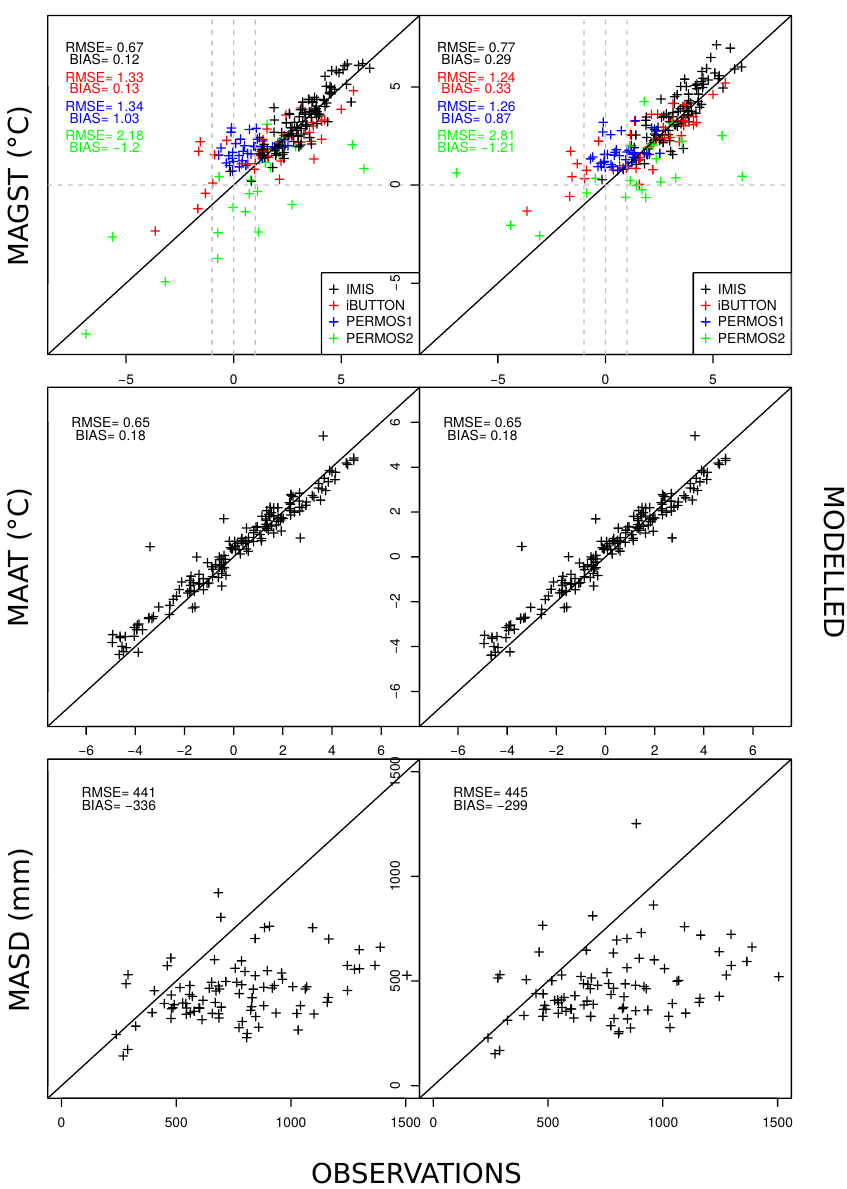
Figure 4. A comparison of MP and MS results. Modelled MAGST, MAAT and MASD evaluated against IMIS sites (2006–2011) together with statistics. Sensitive thresholds of 0 and ± 1 ◦ C are added to aid